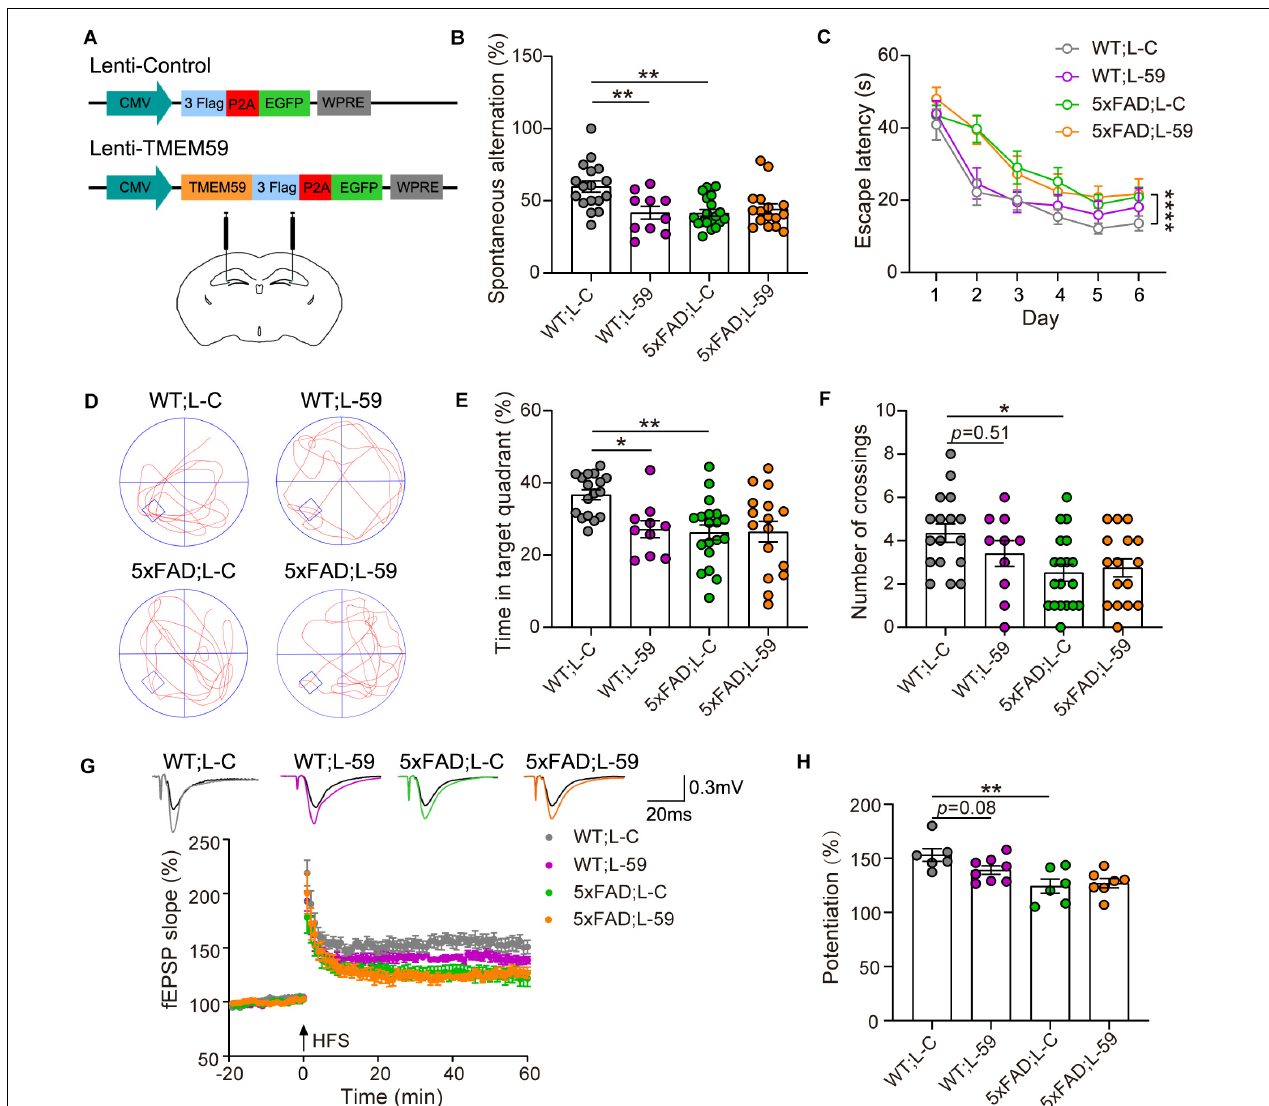
FIGURE 1 | Overexpression of TMEM59 causes memory deficits in mice. (A) The schematic diagram of lentivirus constructs expressing TMEM59 (Lenti-TMEM59, L-59) or control (Lenti-Control, L-C) (upper panels), and their stereotactic injection into the hippocampal region (lower panel). (B) In Y maze tests, spontaneous alternation percentage of WT; L–C ( n = 17), WT; L-59 ( n = 10), 5xFAD; L-C ( n = 19), and 5xFAD; L-59 ( n = 16) mice were calculated for comparison. One-way ANOVA followed by Tukey’s post hoc test. (C–F) In Morris water maze tests, escape latencies during a 6-day training were recorded (C) . Representative swimming paths (D) , time spent in the target quadrant (E) and numbers of platform region crossings (F) during the probe test were also recorded. Comparisons were carried out for WT; L-C ( n = 17), WT; L-59 ( n = 10), 5xFAD; L-C ( n = 19), and 5xFAD; L-59 ( n = 16) mice. Two-way ANOVA followed by Tukey’s post hoc test for comparisons in (C) , and one-way ANOVA followed by Tukey’s post hoc test for comparisons in (E,F) . (G) Time course of fEPSP slopes in the hippocampal CA1 region in acute slices from WT; L-C, WT; L-59, 5xFAD; L-C, and 5xFAD; L-59 mice were recorded. (H) Quantifications and comparisons of average synaptic potentiation from the last 10 min shown in (G) . n = 6 slices for WT; L-C, n = 8 slices for WT; L-59, n = 6 slices for 5xFAD; L-C, and n = 7 slices for 5xFAD; L-59 from 4 to 5 mice per group, Mann Whitney test. Data represent mean ± SEM. * p < 0.05, ** p < 0.01, **** p <